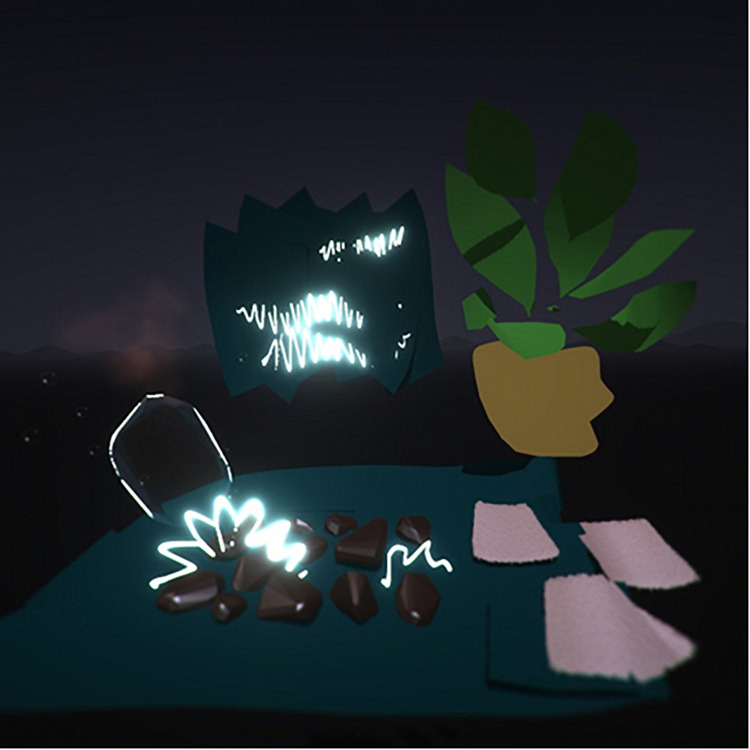
Desk with plants.